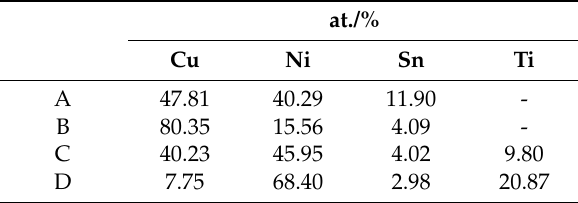
Table 2. EDX analysis results for the position indicated by the arrow A, B, C, and D in Figure 2. at./%